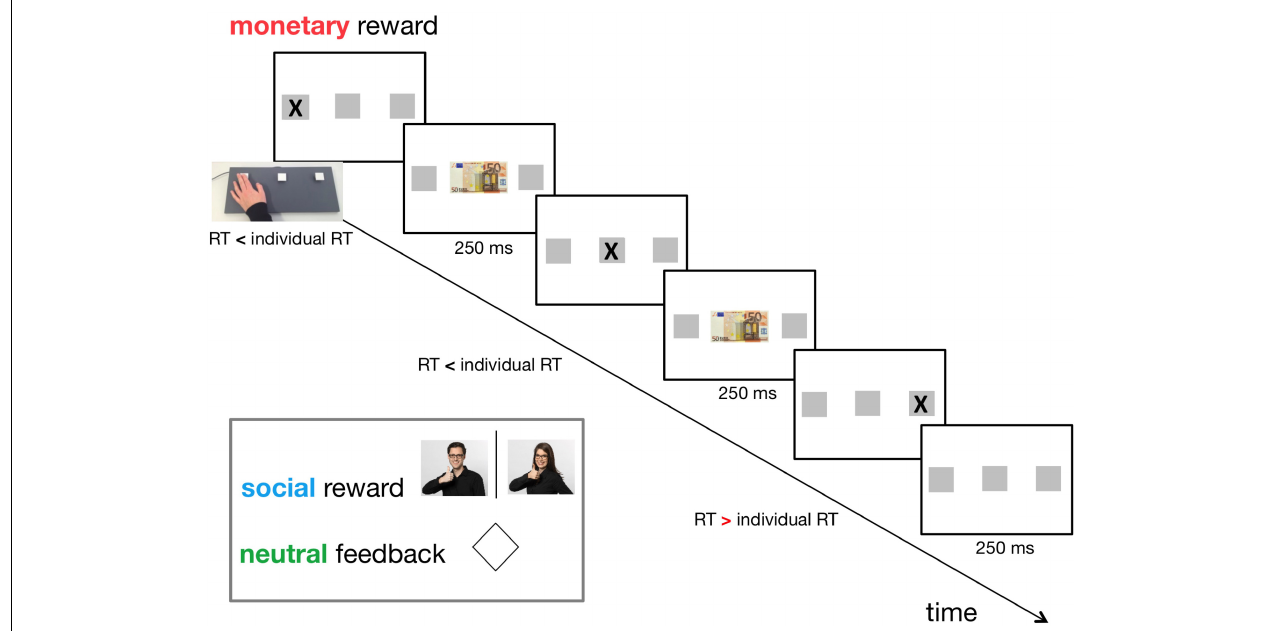
FIGURE 1 | Timeline of the adapted version of the Serial Reaction Time Task (SRT) (day 1). Individual reaction time (RT) had been established in a practice session consisting of 45 random trials before the actual experiment. Three types of feedback were applied in a within-subject design: neutral feedback (for control), social reward, and monetary reward. The feedback was displayed for 250 ms if the participant pressed the correct button on a custom-made three-button keyboard faster than her/his individual RT. An interstimulus interval of 250 ms followed this. In the monetary reward condition, a 50 € banknote was displayed at the centre of the screen. In the social reward condition, a photo of one investigator (CEJD, LM) giving positive feedback was shown. For neutral feedback, a rhombus was displayed at the centre of the